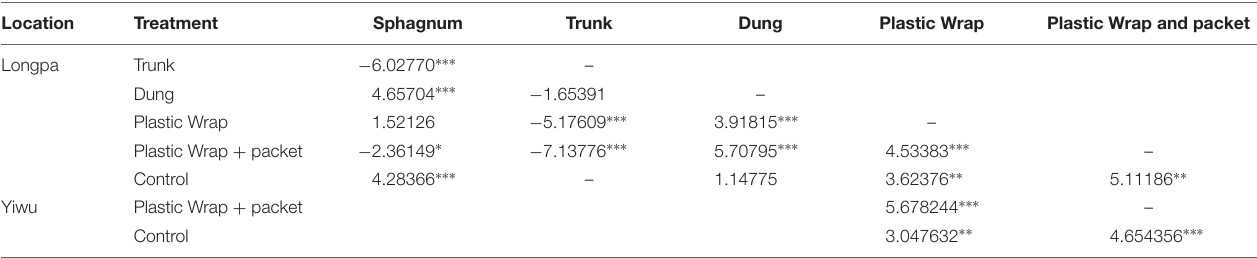
Astericies indicate level of signification associated with each Chi-square statistic ( ∗∗∗ P < 0.0001; ∗∗ P < 0.01; ∗ P <